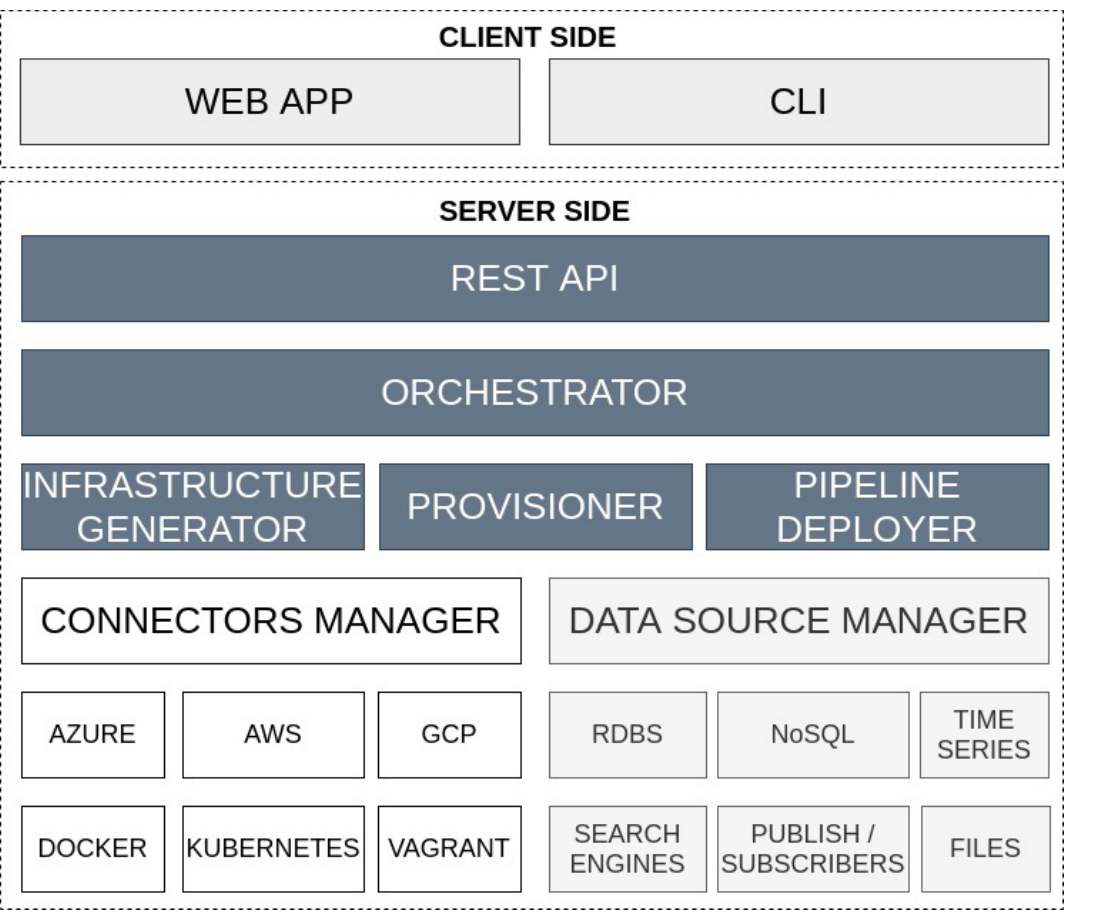
Figure 7. Pangea architecture overview where the specific components derived from the building blocks (see Figure 3) are